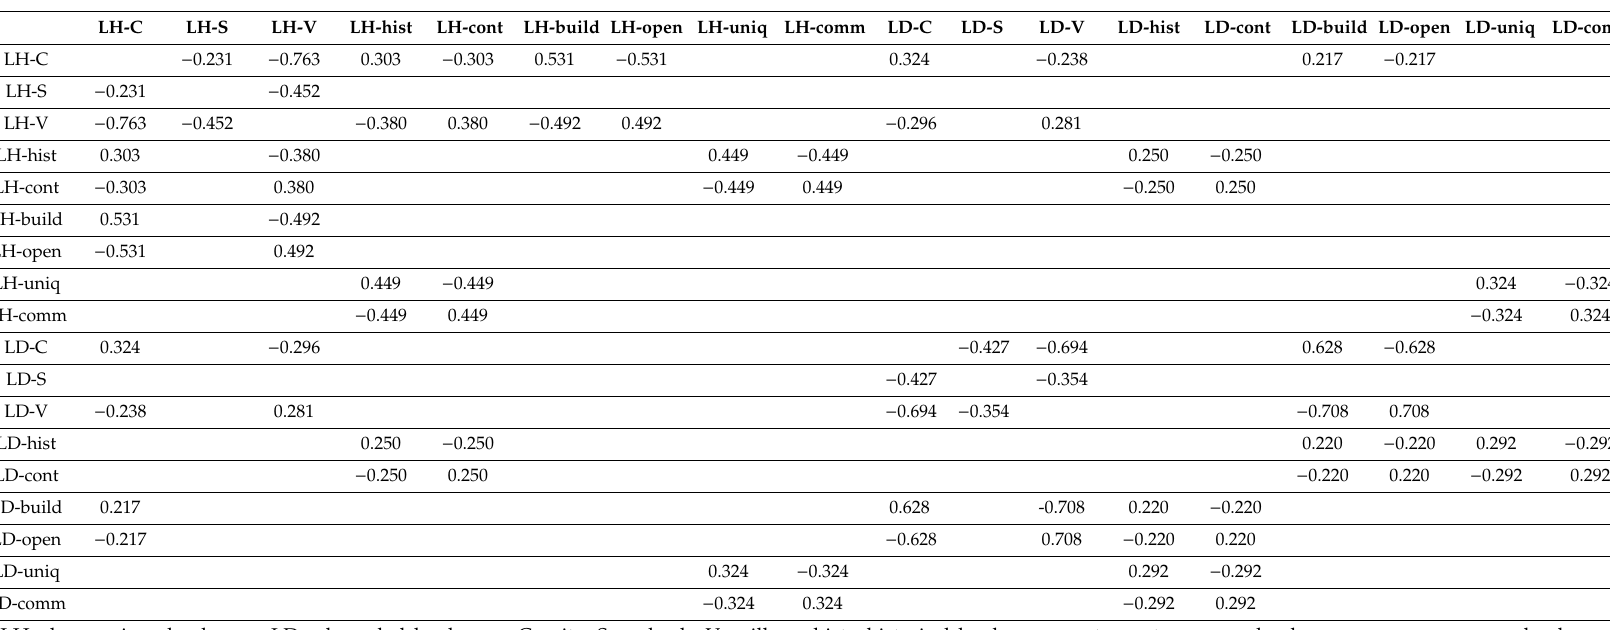
Table 4. Comparison of highly significant correlations ( p > 0.01) between individual characteristics of the harmonious and the degraded landscapes (EnvEng and CivEng students combined, n = 244).